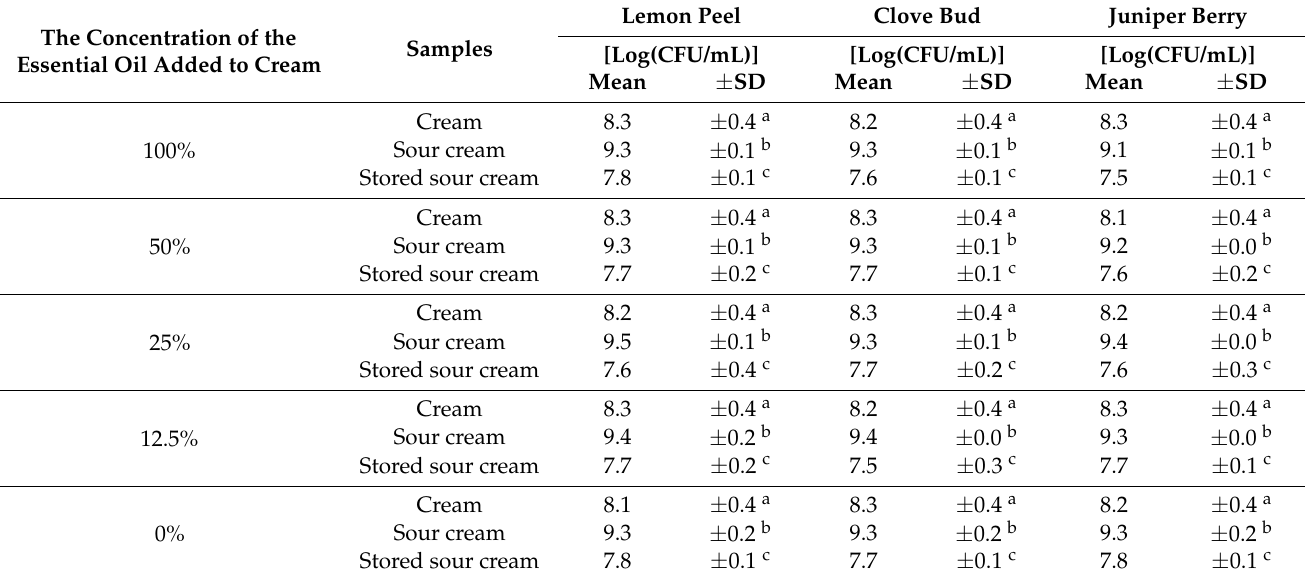
Table 3. Effects of selected essential oils on B. animalis subsp. lactis Bb-12 population (expressed as log(CFU/mL)) in cream and sour cream samples (n =